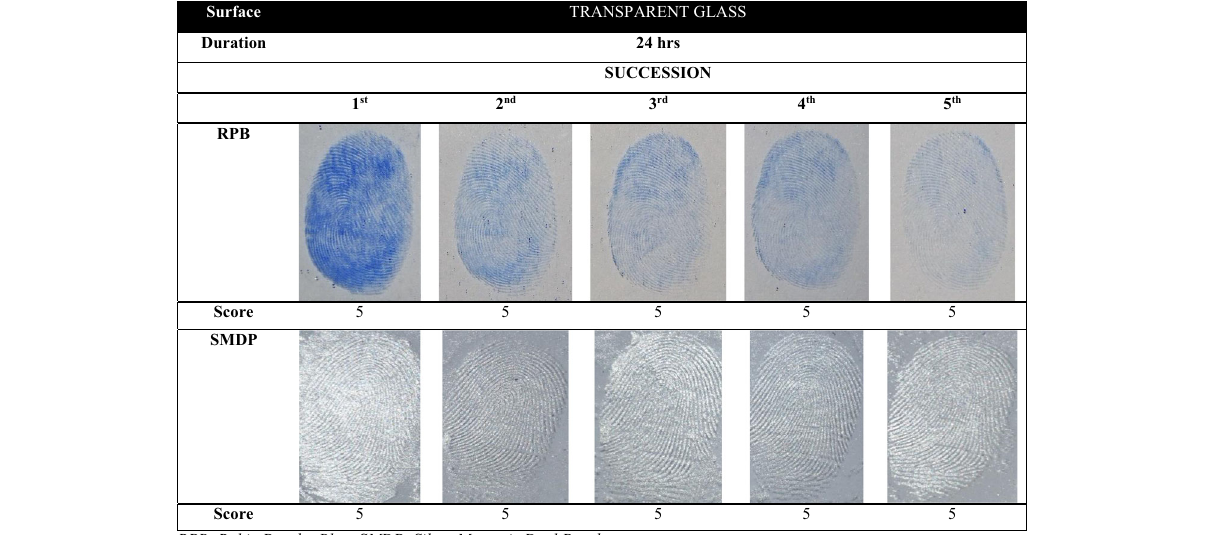
Table 10 Development of submerged and successive prints on transparent glass using Robin powder blue and silver magnetic dual powder Surface